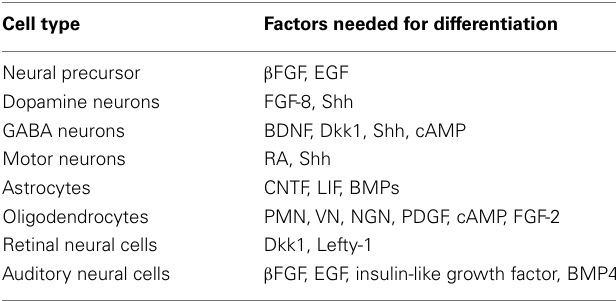
Table 1 | Main factors used for differentiation toward specific neural